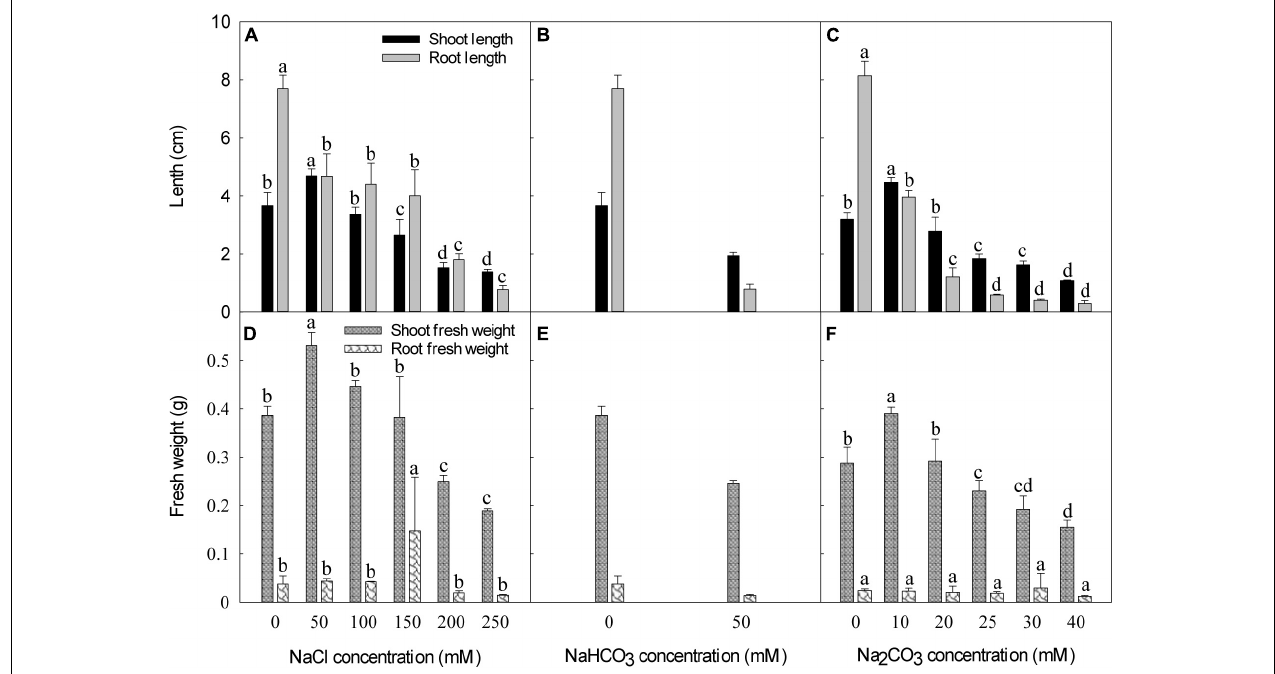
FIGURE 2 | Effect of different NaCl, NaHCO 3 , and Na 2 CO 3 concentrations on shoot and root length (A–C) , and shoot and root fresh weight (D–F) of canola seedlings 7 days after germination. Different lowercase letters indicate the significant differences between salt concentrations within the same growth parameter, according to the least significant difference (LSD) test ( P < 0.05).